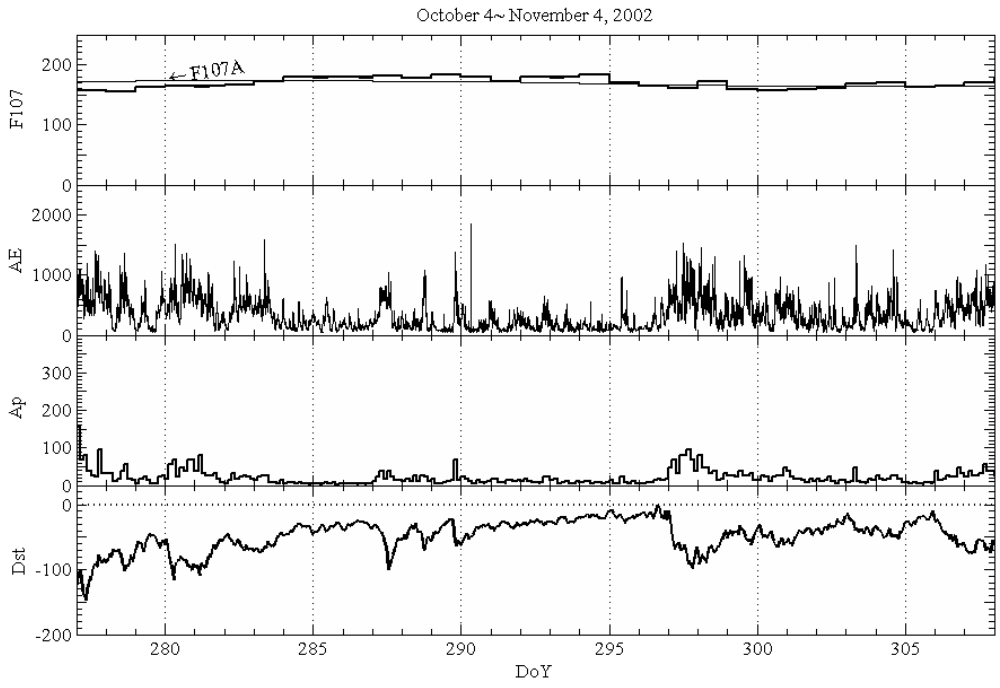
Fig. 1. The solar geophysical conditions during the long-duration Millstone Hill ISR experiment from 4 October and 4 November 2002.